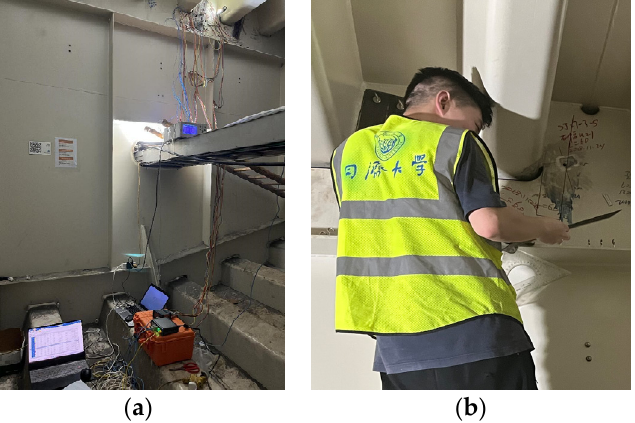
Figure 13. Crack repair of Sutong bridge: ( a ) job site, ( b ) group member in construction.